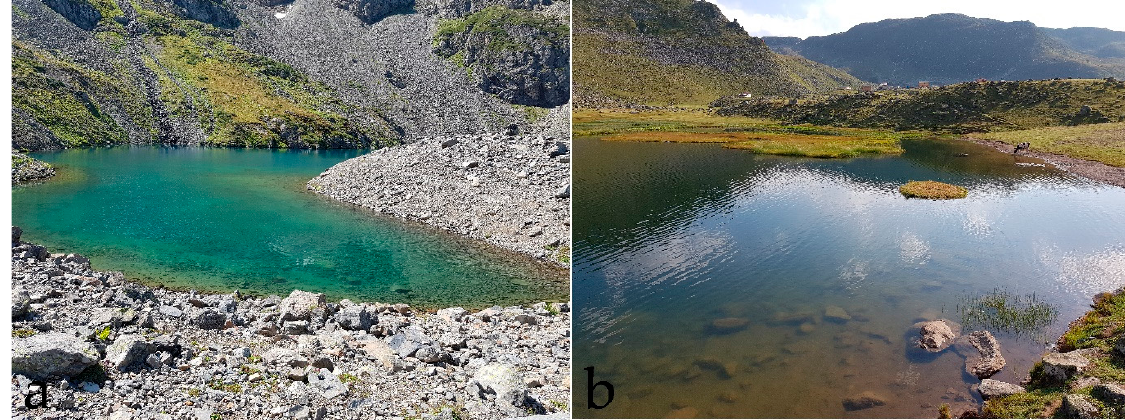
Figure 2. View of the Avusor Great Lake (AGL) ( a ) and Koçdüzü Great Lake (KGL) ( b ).